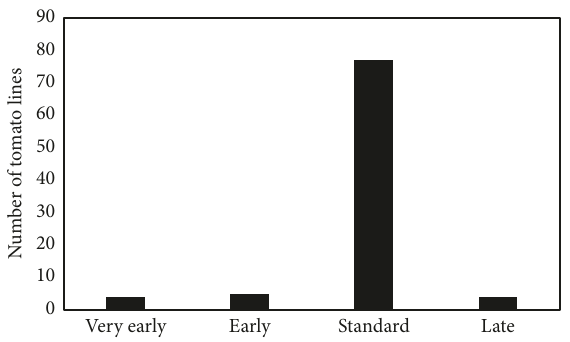
Figure 11: Distribution of ninety-one fresh-market tomato geno- types based on fruit